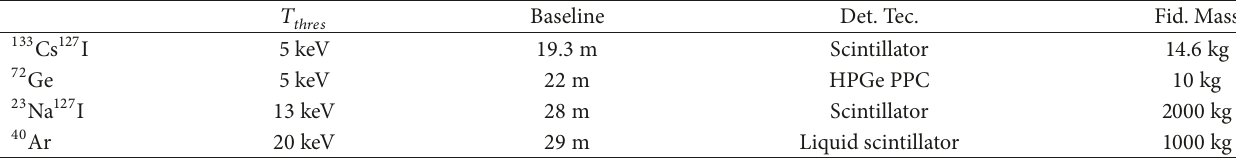
Table 1: Current and future experimental setups for the COHERENT collaboration detectors